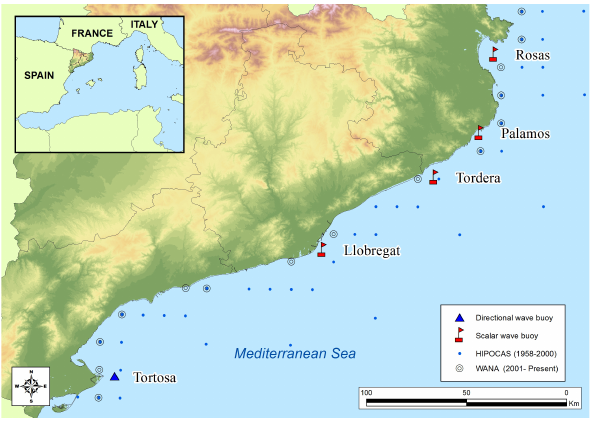
Fig. 1. Study area and location of buoys and wave prediction nodes.